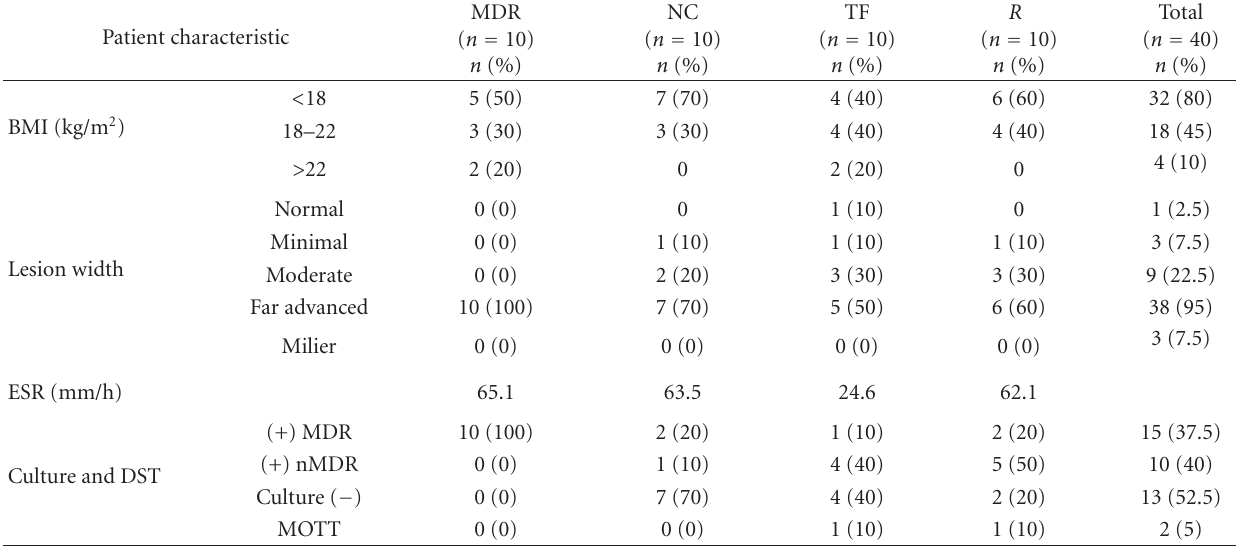
Table 1: Characteristics of tuberculosis (TB) patients at high risk for multidrug resistance (MDR) and multidrug resistant TB. Patient characteristic